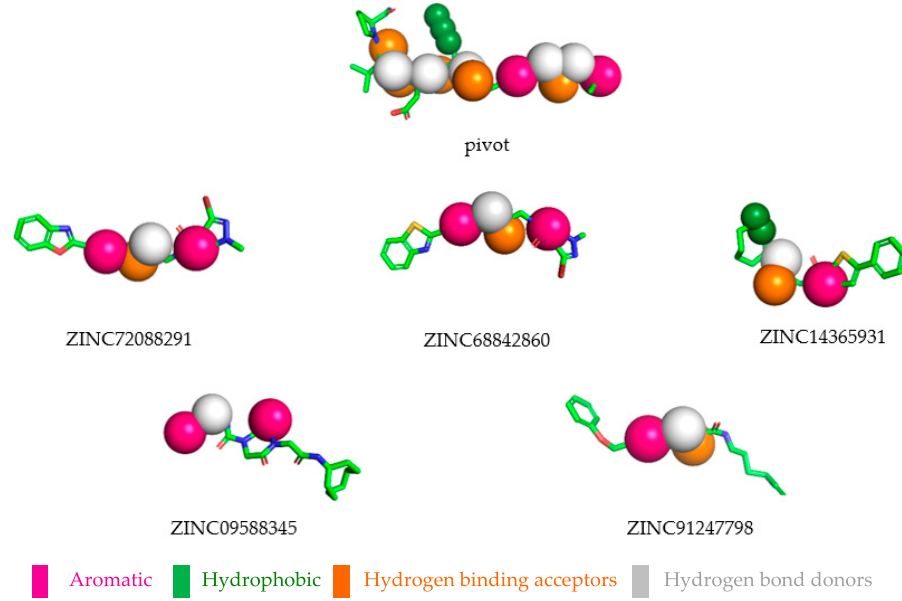
Figure 6. Selected compounds overlapping the pharmacophore.